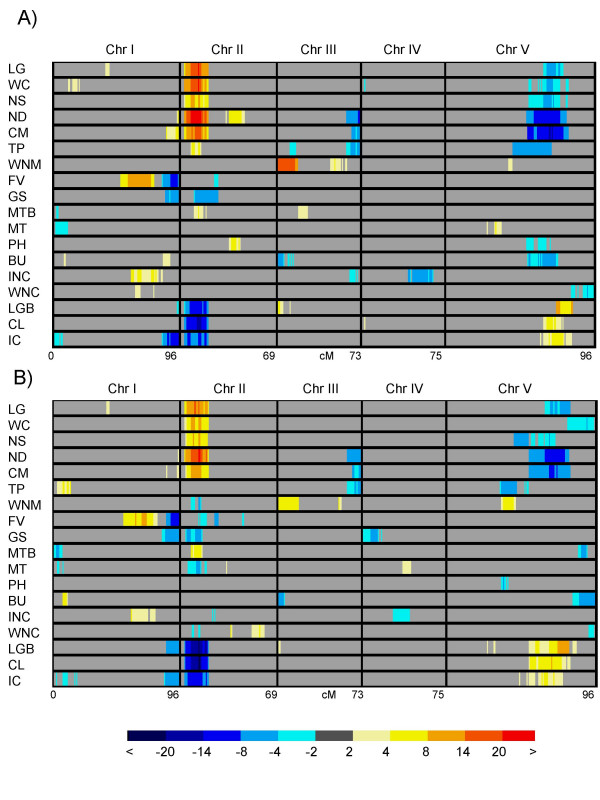
Network eQTL controlling a priori defined gene expression networks. The vertical lines separate the genome into chromosomes I-V (labeled at the top) with cM progressing left to right along the x axis, and the length of each chromosome in cM is at the end of each chromosome. The color schematic shows the LOD plot for each gene with the directionality of effect indicated by the color. Only significant QTLs are shown. A network eQTL where the Bay-0 allele has a positive effect is shown by differing shades of yellow and red, and darker intensity indicates a greater LOD score at that genetic position. A QTL where the Bay-0 allele has a negative effect is shown by differing shades of blue, again with darker intensity indicating a greater LOD score. The networks are ordered using median centered Spearman rank clustering of the effect traces along the genome; as a result, networks showing similar network eQTLs and effect directionality are located adjacent to each other. A. Network eQTL for gene expression networks obtained using mean-cis. B. Network eQTL for gene expression networks obtained using meanz.